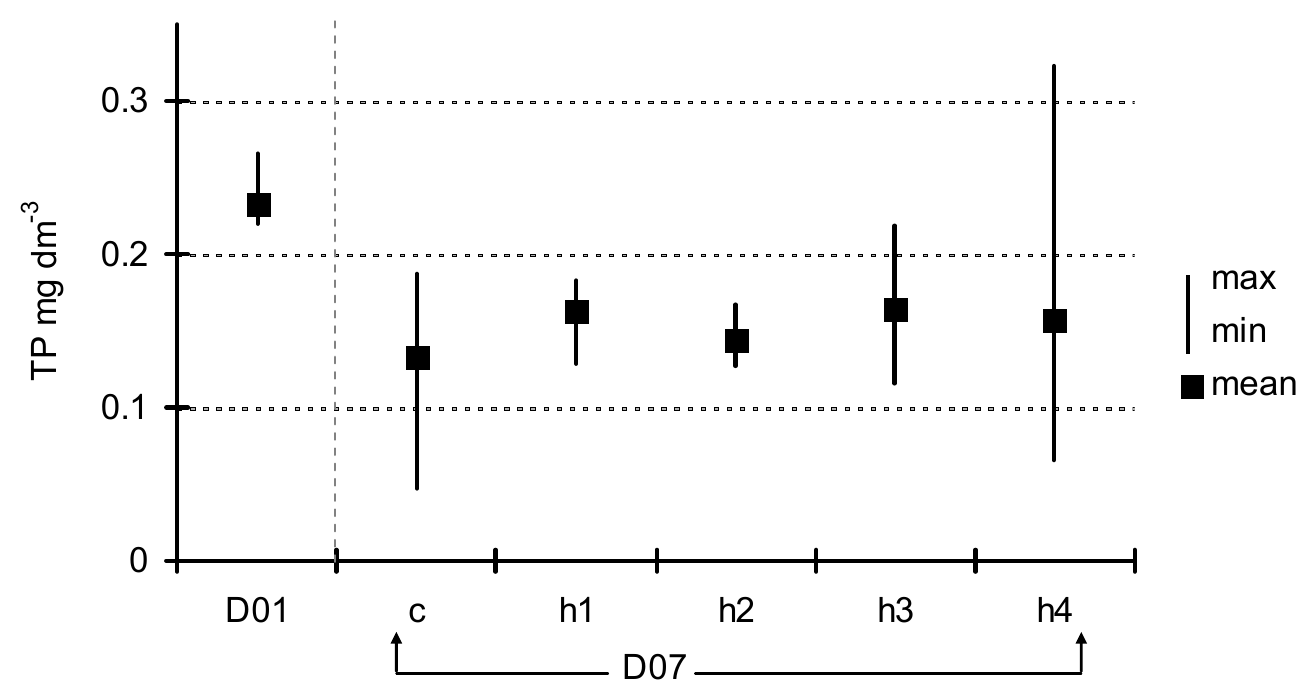
Figure 4. Change in TP concentration between D01 and D07. Observed differences were not signifi- cant (ANOVA at p < 0.05).